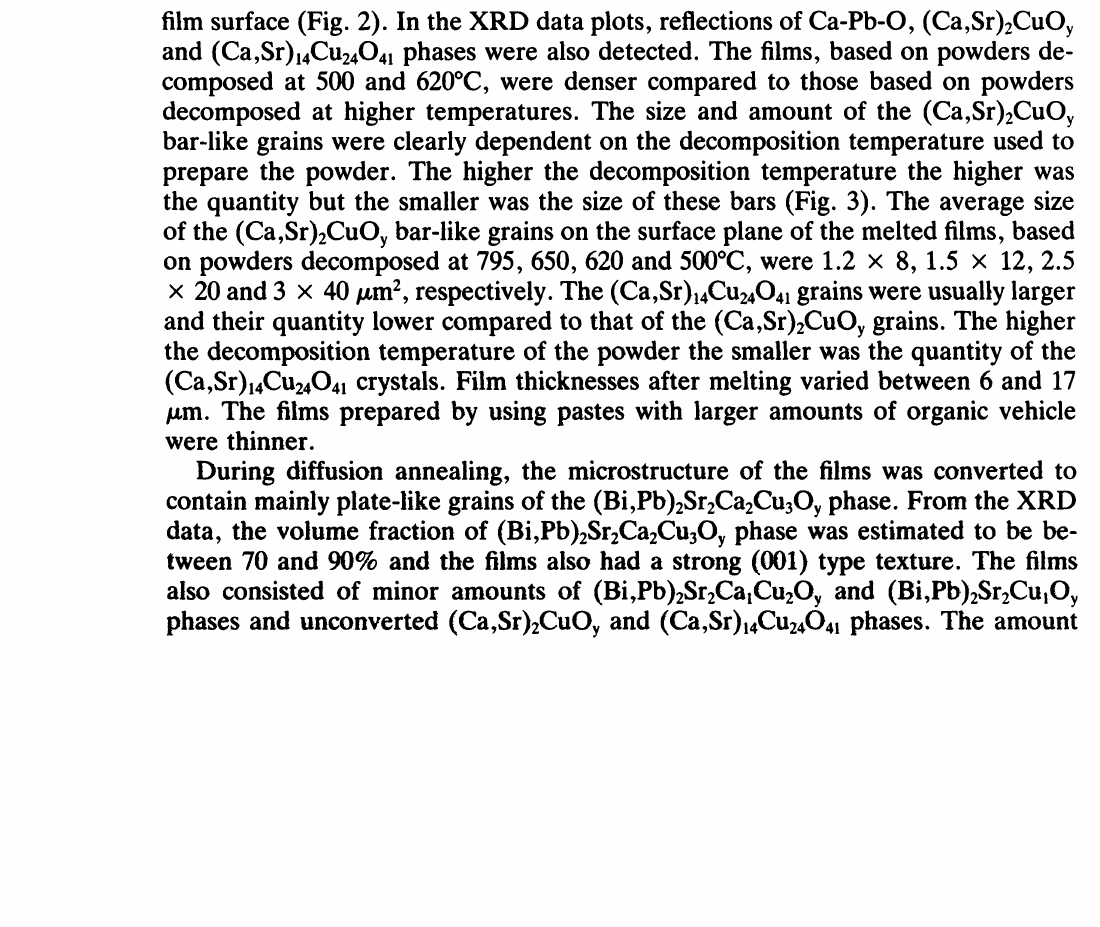
FIGURE 2 XRD-spectra of a thick film melt annealed at 895C for 3